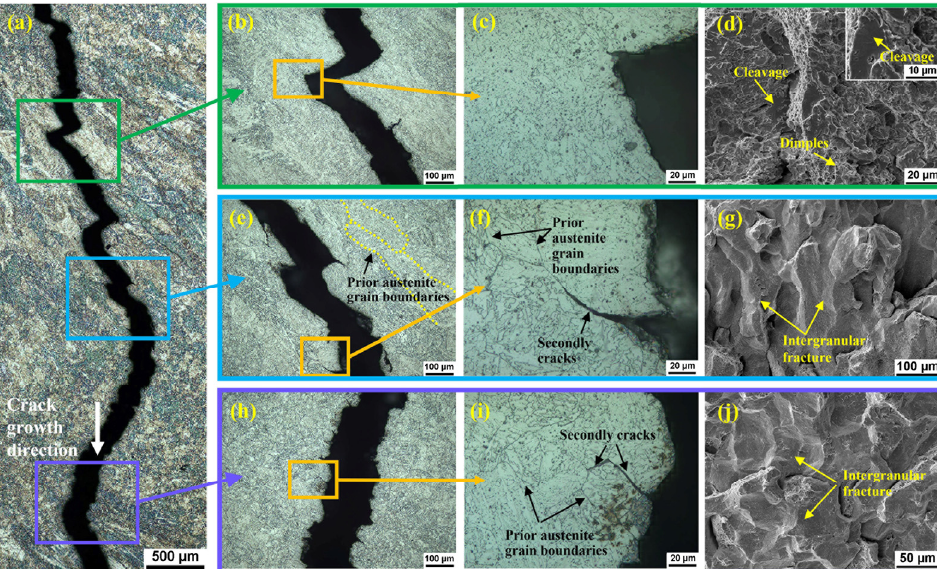
Figure 10. The crack growth path and the fracture morphology of the impact specimen in the turbine part WM: ( a ) the crack growth path; ( b – d ) the upper part of columnar zone; ( e – g ) the lower part of columnar zone; ( h – j ) the interlayer zone.